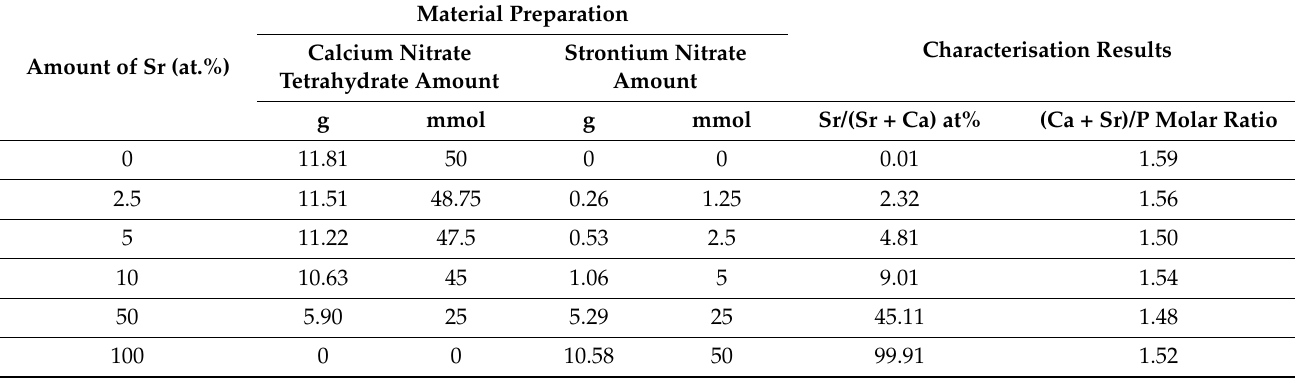
Table 2. Reagent amounts used to produce SrHA (0, 2.5, 5, 10, 50 and 100 at.% Sr) using rapid-mixing sol-gel method. Strontium incorporation and (Ca + Sr)/P molar ratio achieved, characterised using X-ray fluorescence.